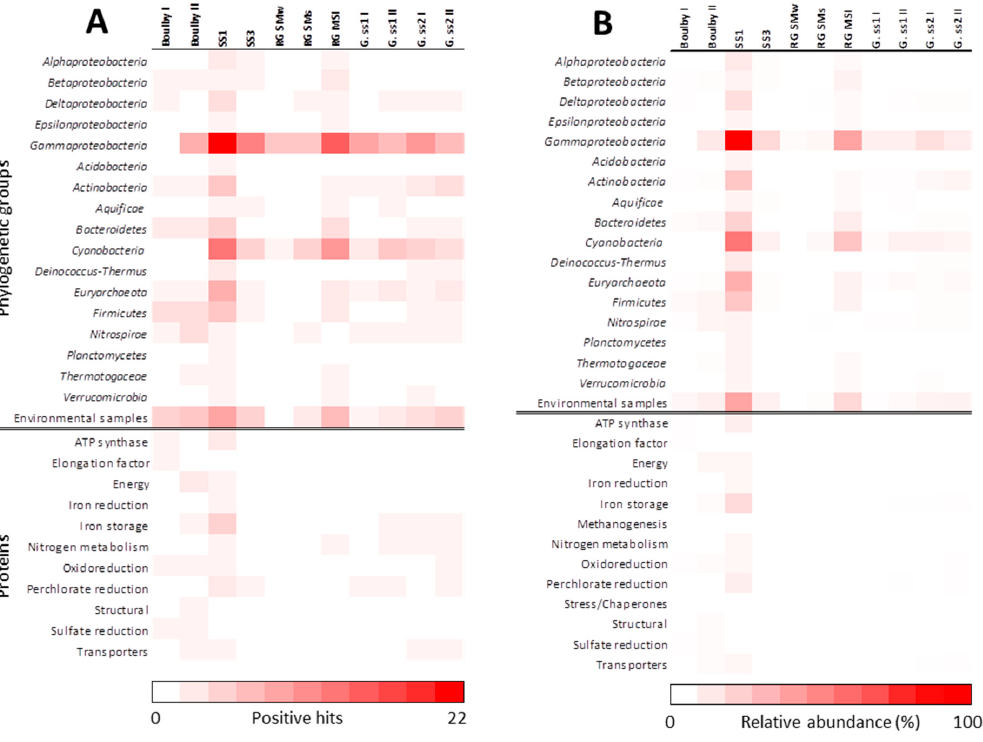
Figure 3. Heat map showing the results obtained with the Life Detector Chip (LDChip)168 immunoassay in samples from MASE sites (Boulby I (Bou-I) and Boulby II (Bou-II) from Boulby Mine (hypersaline environment); IS.SS1 and IS.SS3 from Iceland-Gr ᴂ nvatn Lake (acidic lake); RG. SMw (water) and RG. SMs (sediments) from Sippenauer Moor (sulfidic spring SM); RG. MSI form Islinger Mühlbach Schewefelquelle (sulfidic spring IM); and G.ss1-I, G. ss1-II, G. ss2-I, G. ss2-II from Kaunertal Glacier, Austria (glacier). The antibodies that showed positive immunodetections were clustered by phylogeny of the targets, protein function, or environmental origin and plotted in a scale from white to red. ( A ) The number of hits is represented from 0 to 22, as the maximum number of hits of antibodies (Abs) from the same group detected in a sample. Here, certain underestimations may result from representing the positive immunodetections in those groups with a lower number of antibodies represented in the chip. In ( B ), the number of hits was normalized by the relative weight of each group represented in the chip and expressed as the relative abundance in percentage. The